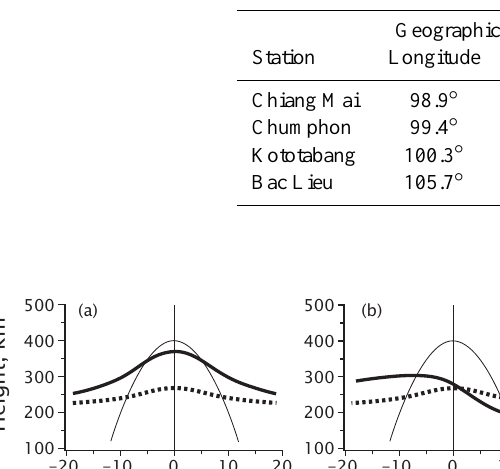
Table 1. Parameters for SEALION ionosonde stations.